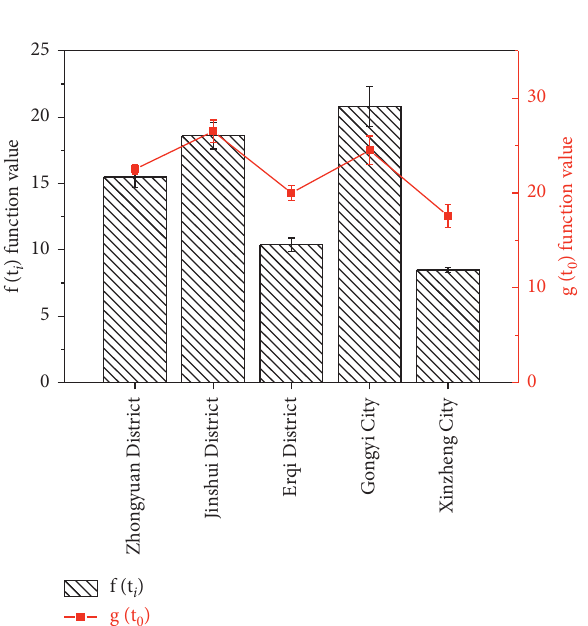
Figure 3: The function values of f ( t